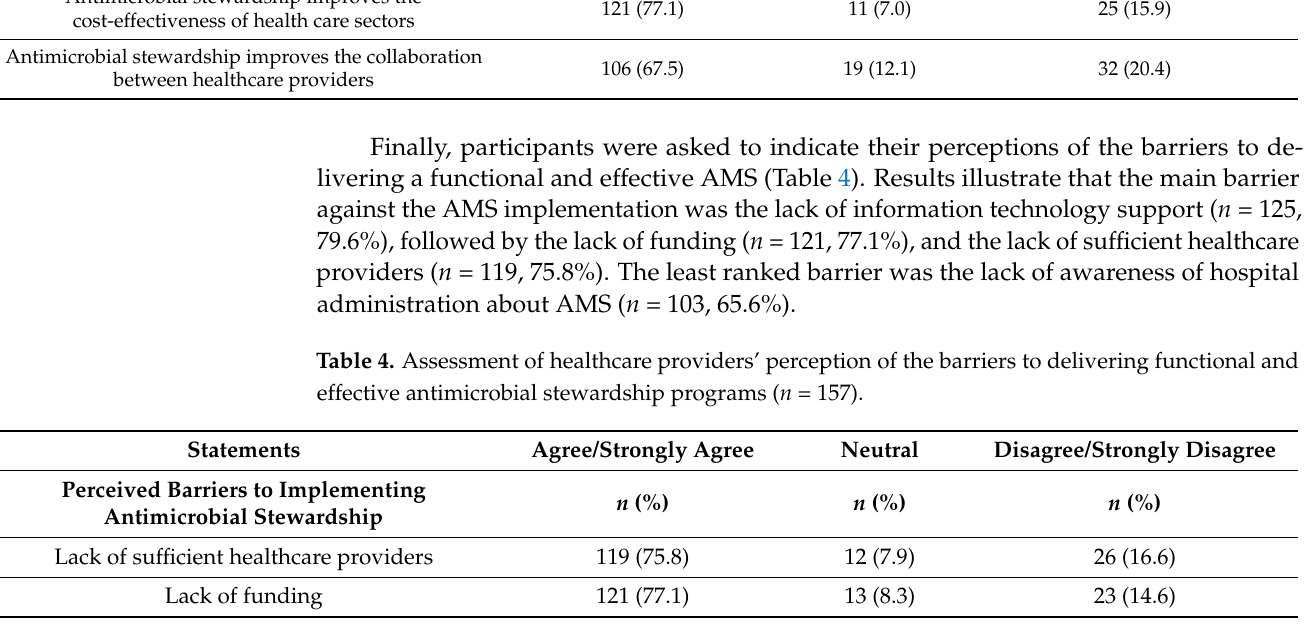
Table 3. Assessment of healthcare providers’ perception towards the importance of antimicrobial stewardship programs ( n = 157).